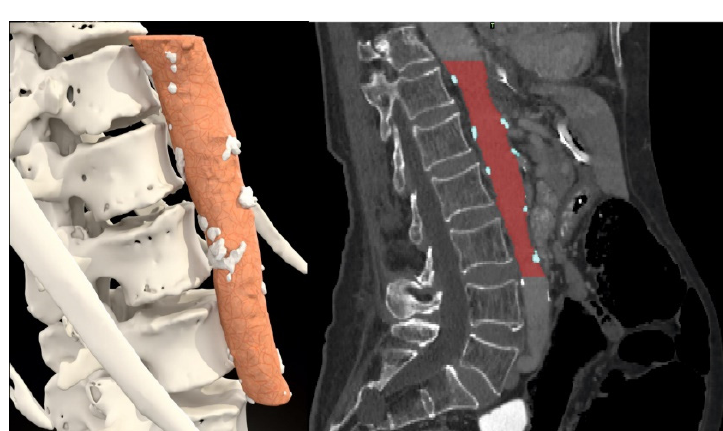
Figure 5. Calcification plaque measurement in aorta.